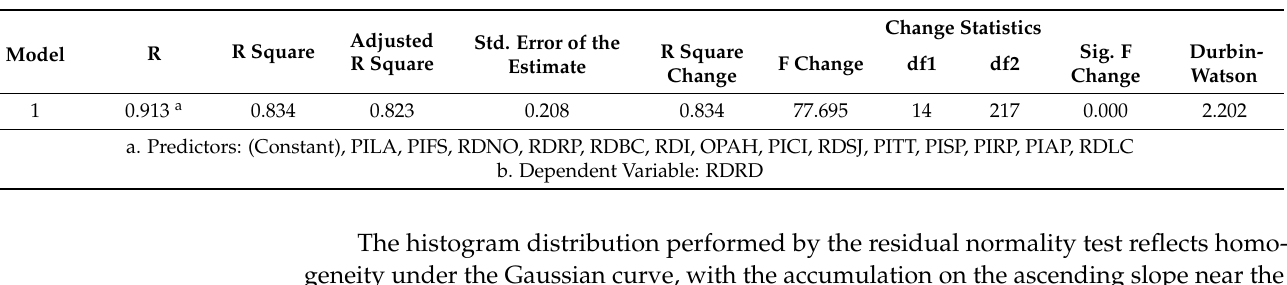
Table 2. Model Summary b